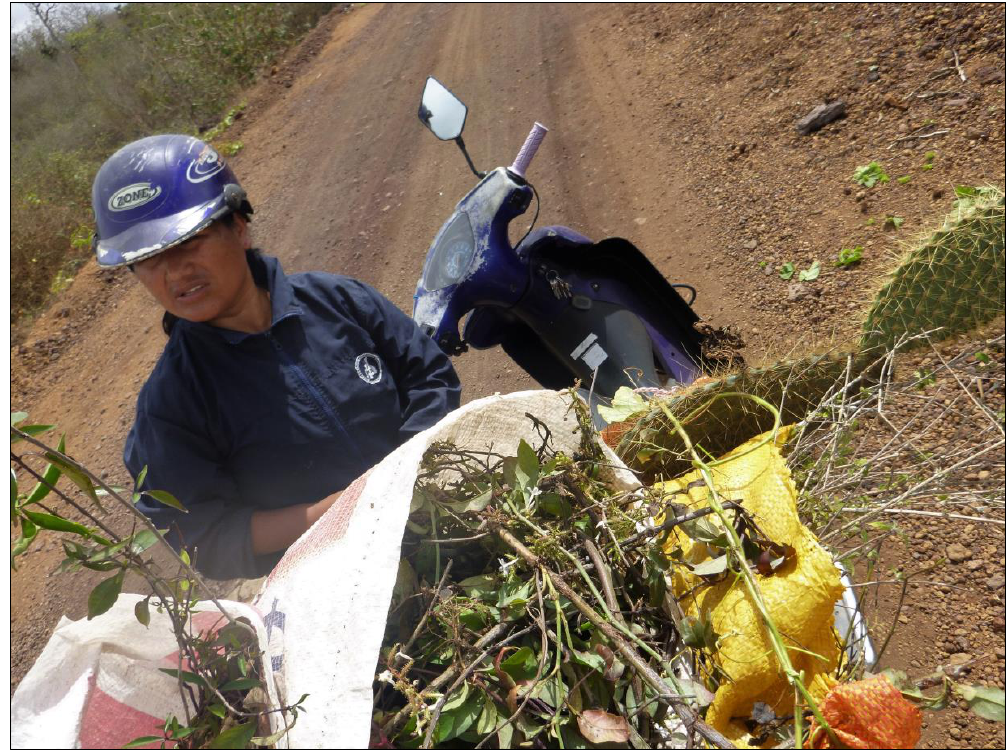
Figure 4. The harvest. Photo by author.